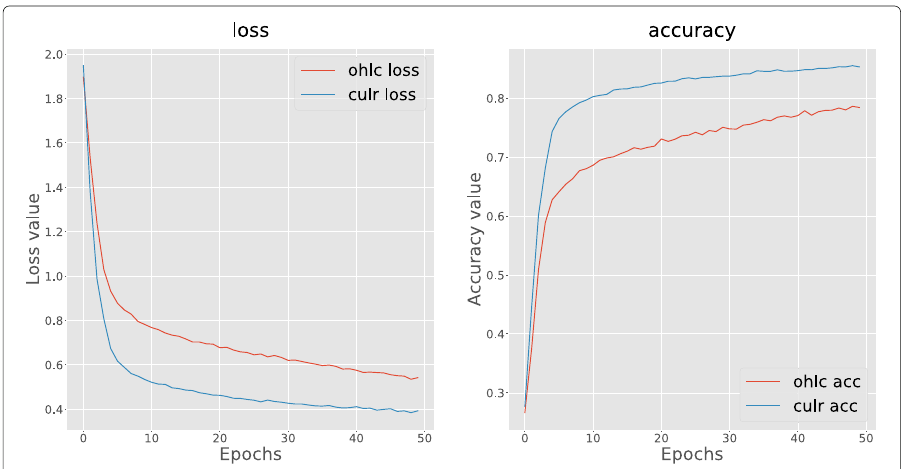
Fig. 17 The loss and accuracy are from the first 50 epochs within two feature sets